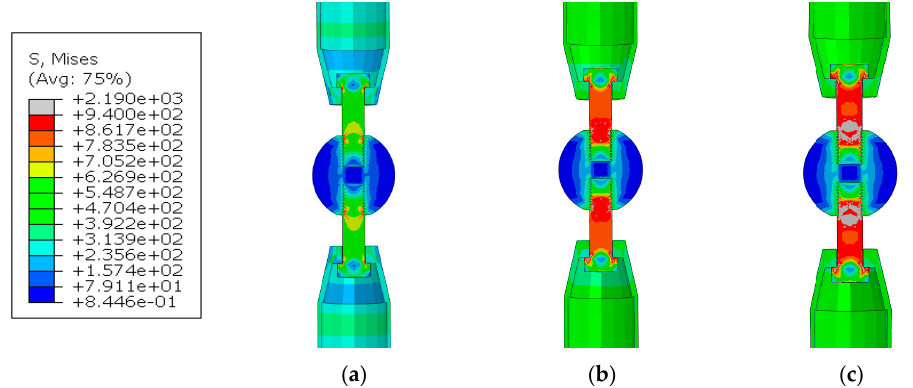
Figure 18. Stress diagrams of the bolt-sphere joint with members: ( a ) initial loading; ( b ) mid-term loading; ( c ) postloading.